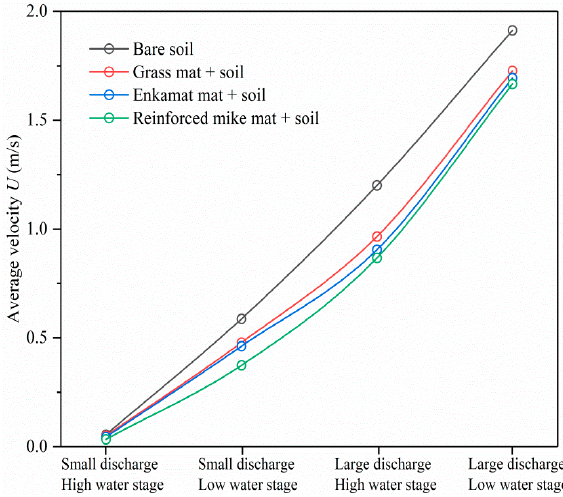
Figure 3. Distribution law for average velocity U under different flow conditions.